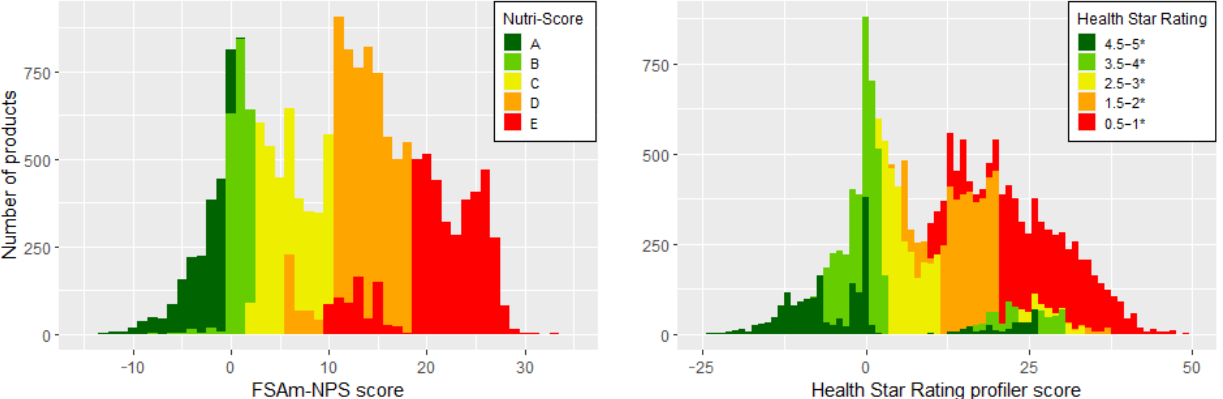
Figure 1. Overall distribution of profiling scores according to Nutri-Score (FSAm-NPS (Food Standard Agency- Nutrient Profiling System)) and Health Star Rating algorithm in conjunction with their final grade. Colours represent different Nutri-Score and Health Star Rating grades across 2020 Slovenian food supply (n = 17,226). * refers to stars of Health Star Rating grades.